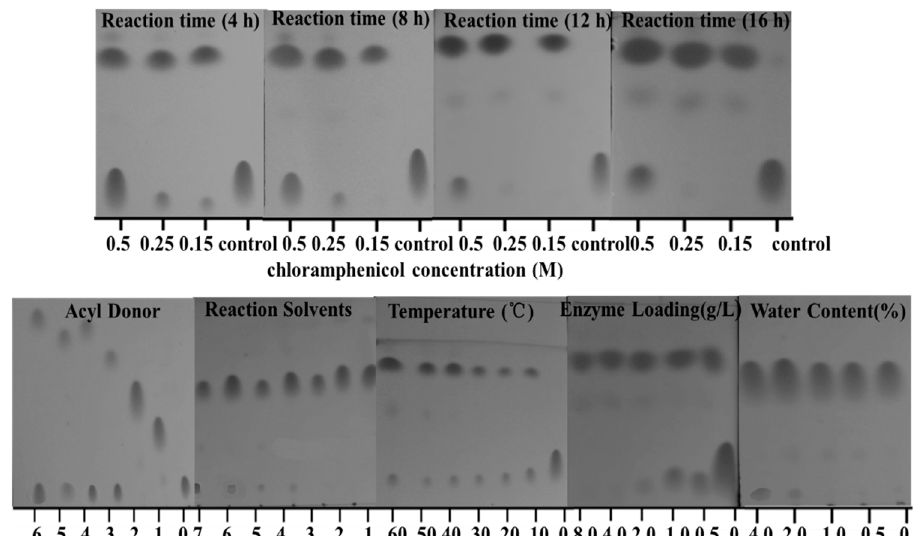
Figure 3. Effect of the reaction conditions on the conversion of chloramphenicol. Reaction conditions: Chloramphenicol concentration: 0.15, 0.25, 0.5 M; acyl donor: 0: control, 1: vinyl acetate, 2: vinyl